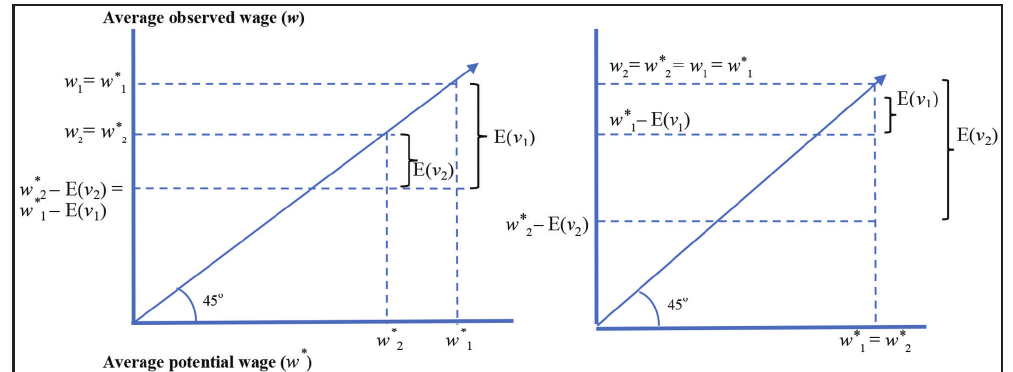
Differences between observed and potential wage